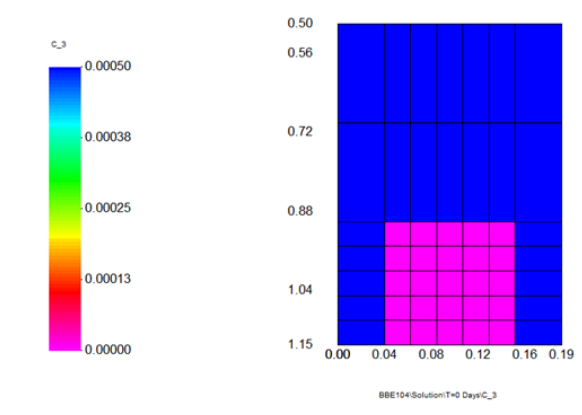
Figure 6: Initial surfactant concentration (volume fraction) for the imbibition test model. The vertical XZ cross section through the center (at Y-slice=4) of the model.